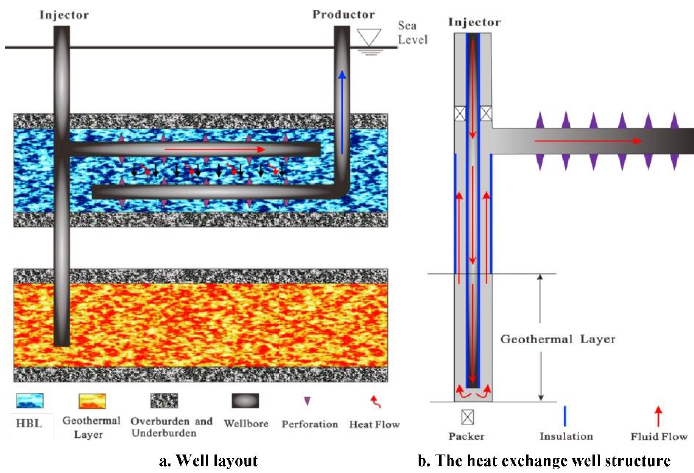
Figure 19. Schematic well group configuration diagram of the geothermal-assisted CO 2 replacement method (GACR)